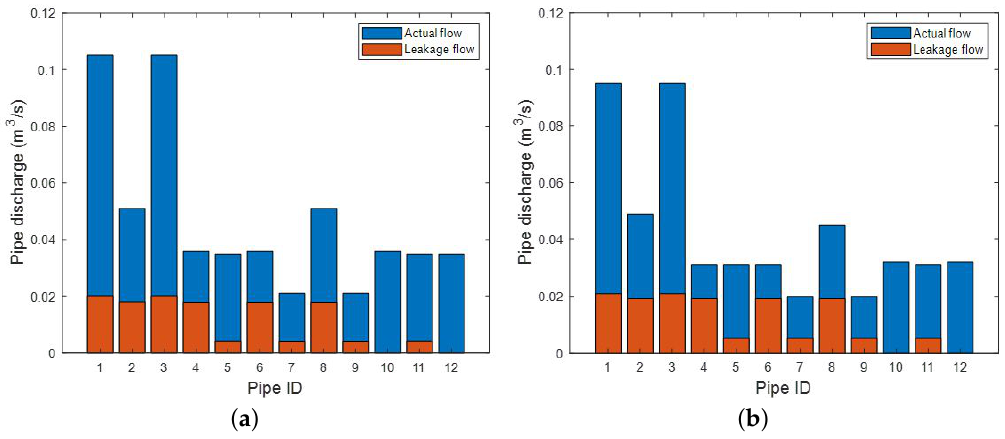
Figure 3. The pipe discharge and the leakage flow in each pipe for the case study network 1: ( a ) DDM analysis; ( b ) PDM